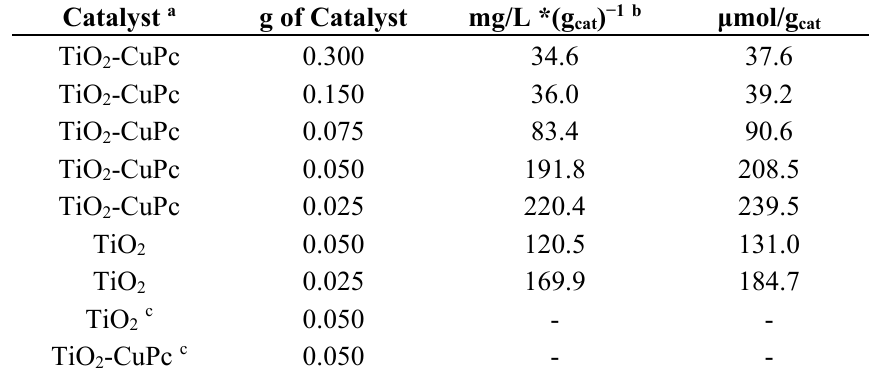
Table 1. Effect of photocatalyst amount on formic acid production efficiency at pH = 3.